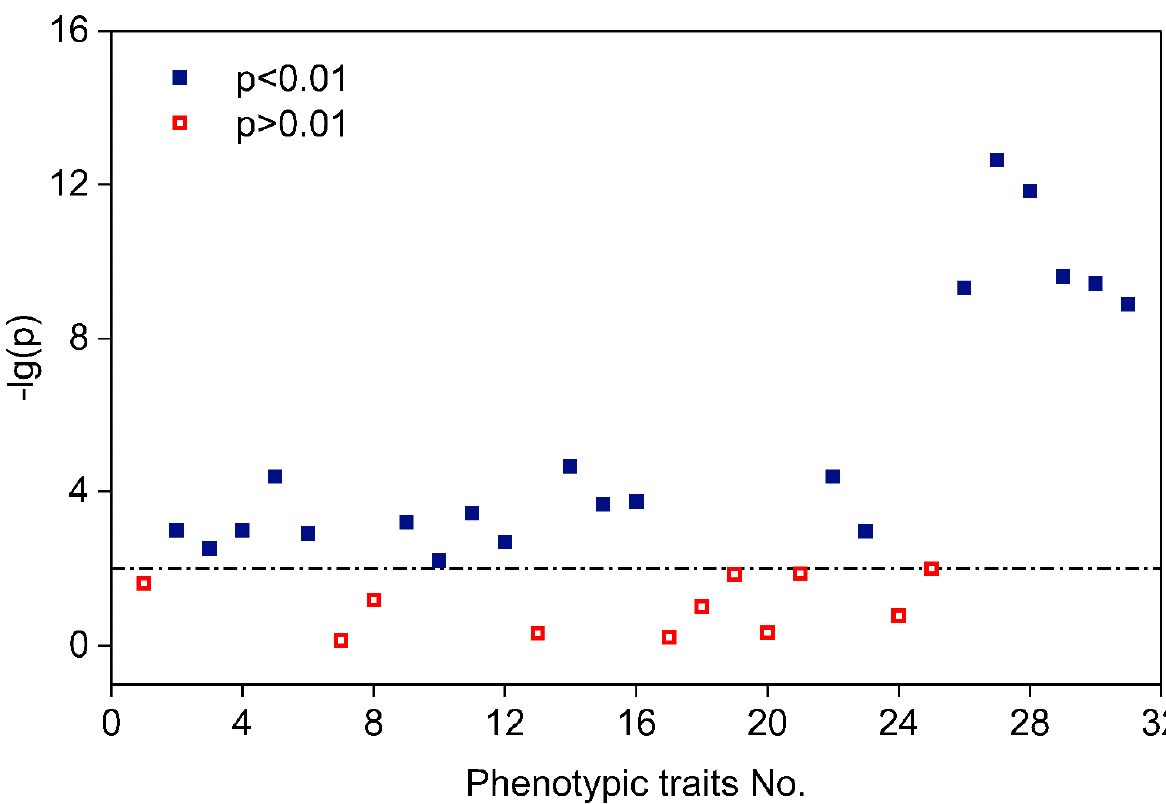
Figure 6. Significance analysis of phenotypic features with a p -value threshold of 0.01. Note: Solid and hollow squares indicate the conditions p < 0.01 and p > 0.01, respectively. Horizontal line represents p = 0.01, i.e., − lg (p) = 2.